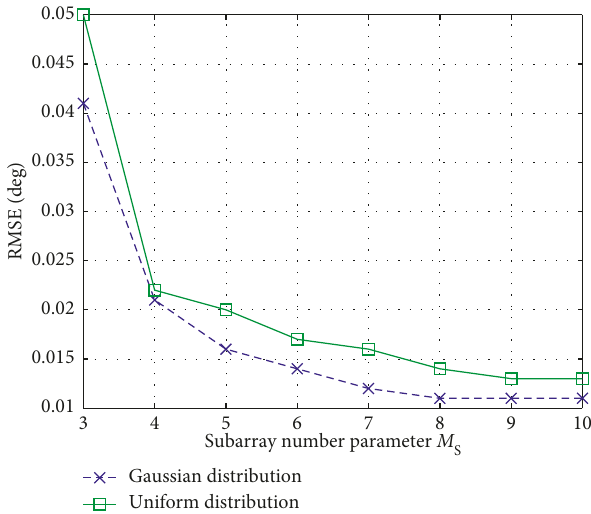
Figure 6: RMSE estimated by the proposed versus M